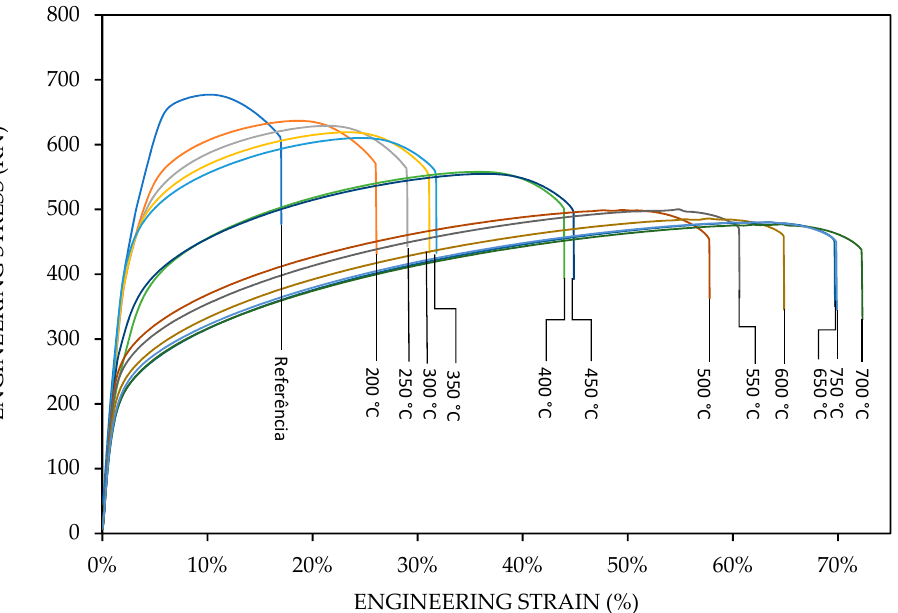
Figure 7. Evaluation of the strength and ductility parameters of samples that were heat-treated for 200, 250, 300, 350, 400, 450, 500, 550, 600, 650, 700, and 750 °C.